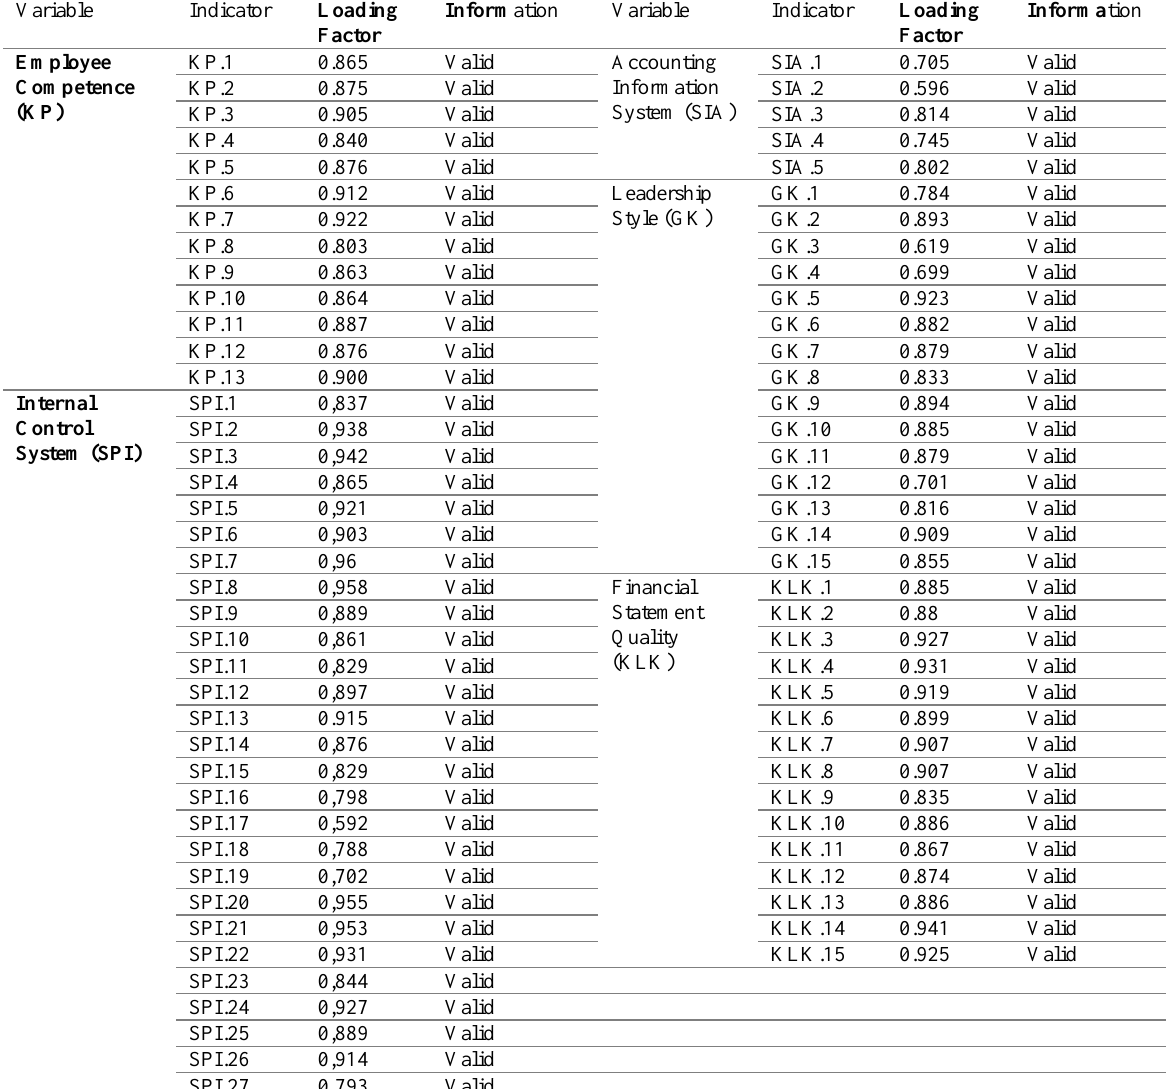
Table 1: Reflective Construct Convergent Validity Test